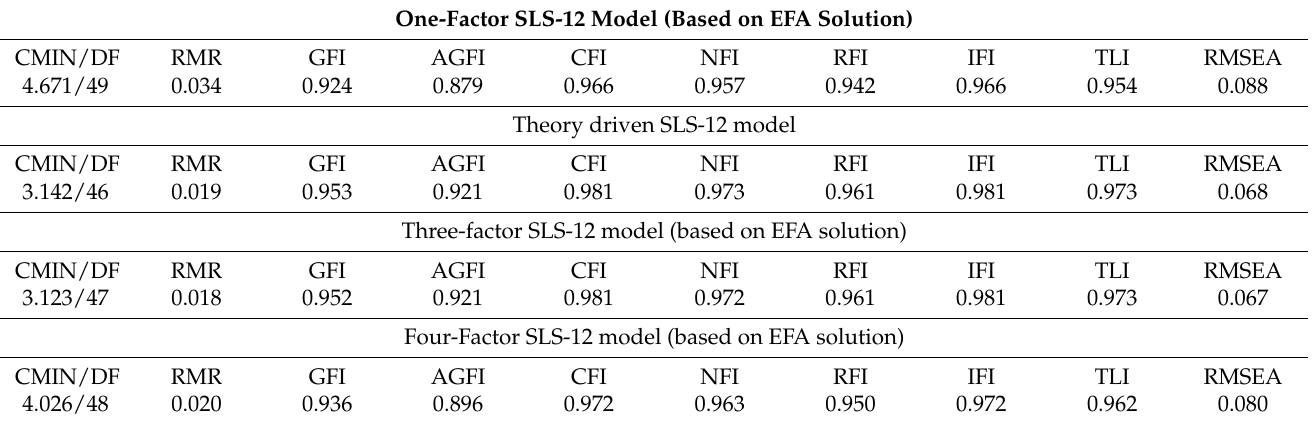
Table 3. Confirmatory factor analysis of the SLS-12 scale (N = 470).